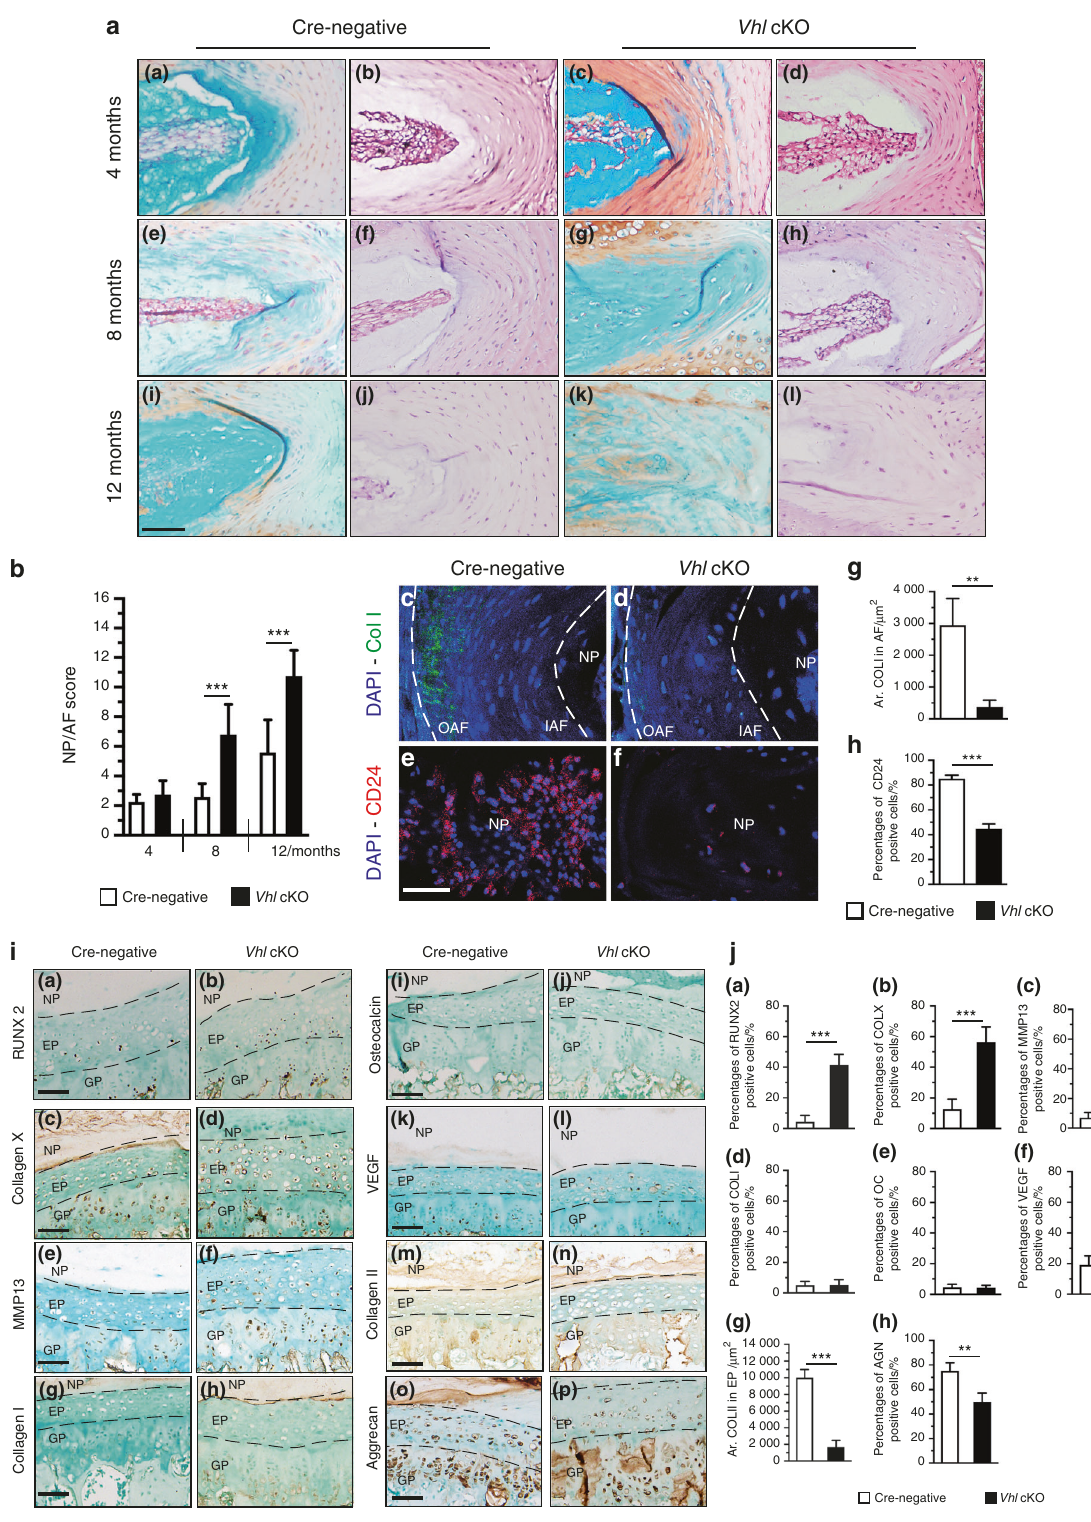
Fig. 4 Aberrant Hif1 α activation causes degenerative changes in IVD tissues. a Fast green/Safranin O- and H&E-stained coronal sections of the AF and NP from WT and Vhl cKO mice. b Histological degenerative scores of NP/AF tissues in WT and Vhl cKO mice. c , d Representative COLI immuno fl uorescence images of IVDs from the lumbar AF of 12-month-old WT and Vhl cKO mice (green: anti-ColI; blue: Hoechst) ( n = 3 – 4). e , f CD24 signals were analyzed by immuno fl uorescence assay from NP cells of WT and Vhl cKO mice at the age of 12 months. (red: anti-CD24; blue: Hoechst) ( n = 3 – 4). g – h Quantitative analysis of COLI + cells and CD24 + cells in the EP and AF of Vhl cKO and control mice. i Immunostaining and j quantitative analysis of RUNX2 + cells, COLX + cells, MMP13 + cells, COLI + cells, OC + cells, VEGF + cells, COL2AL and aggrecan in lumbar discs from WT and Vhl cKO mice at the age of 4 months ( n = 3 per group). Scale bar: 50 µm ( a , c – f , i ). Data are expressed as the percent expression relative to controls. Values represent the mean (symbols) ± SD (error bars). *P < 0.05 ; **P < 0.01 ; ***P < 0.001